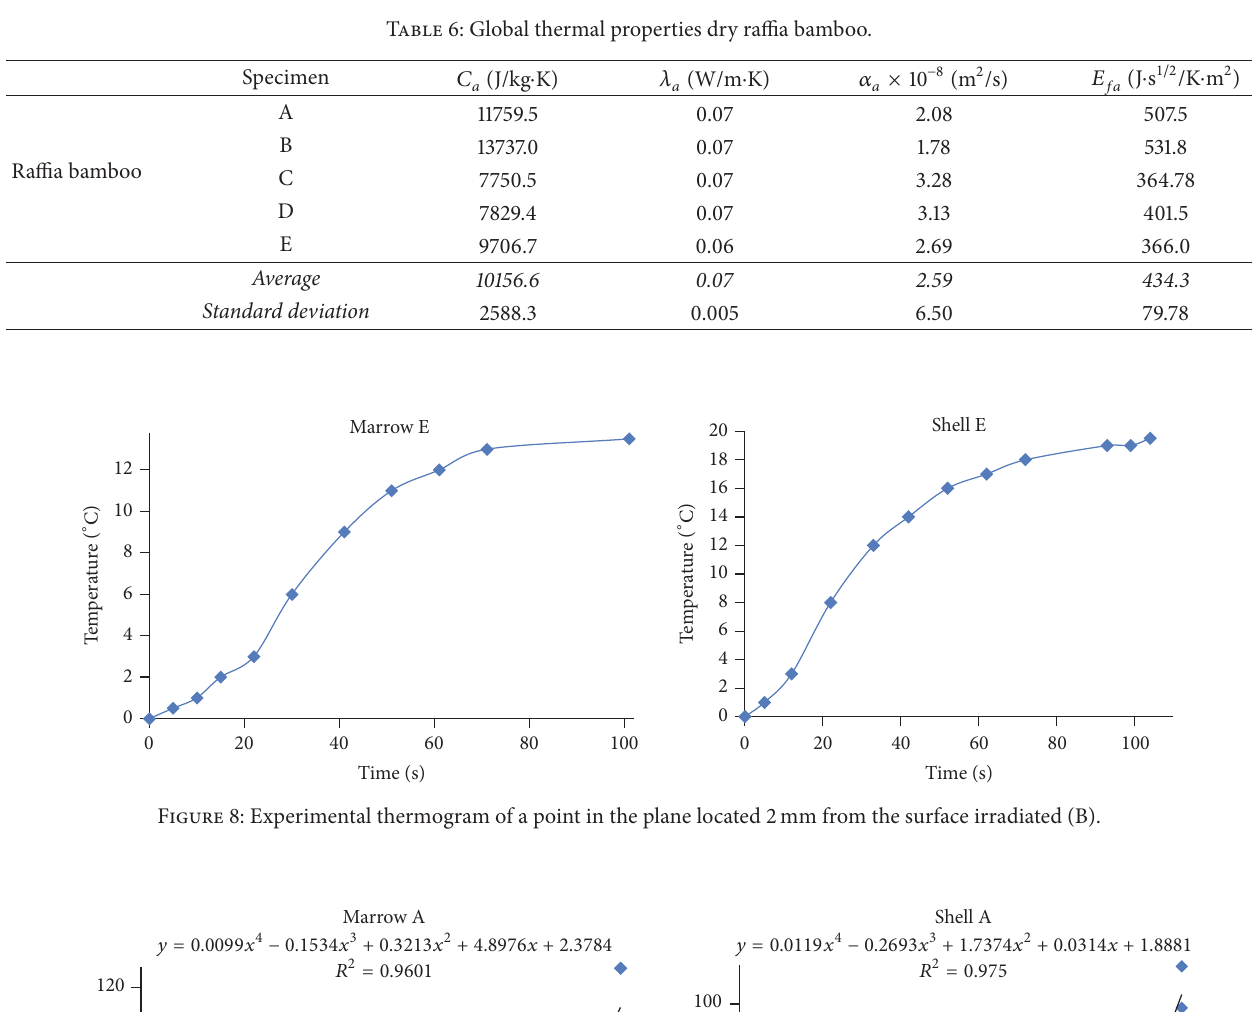
that of the marrow is smaller and close to 0.04 W/m ⋅